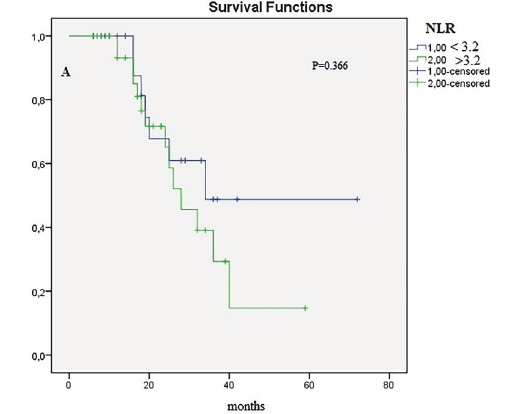
Figure 2A -Kaplan-Meier curve for NLR